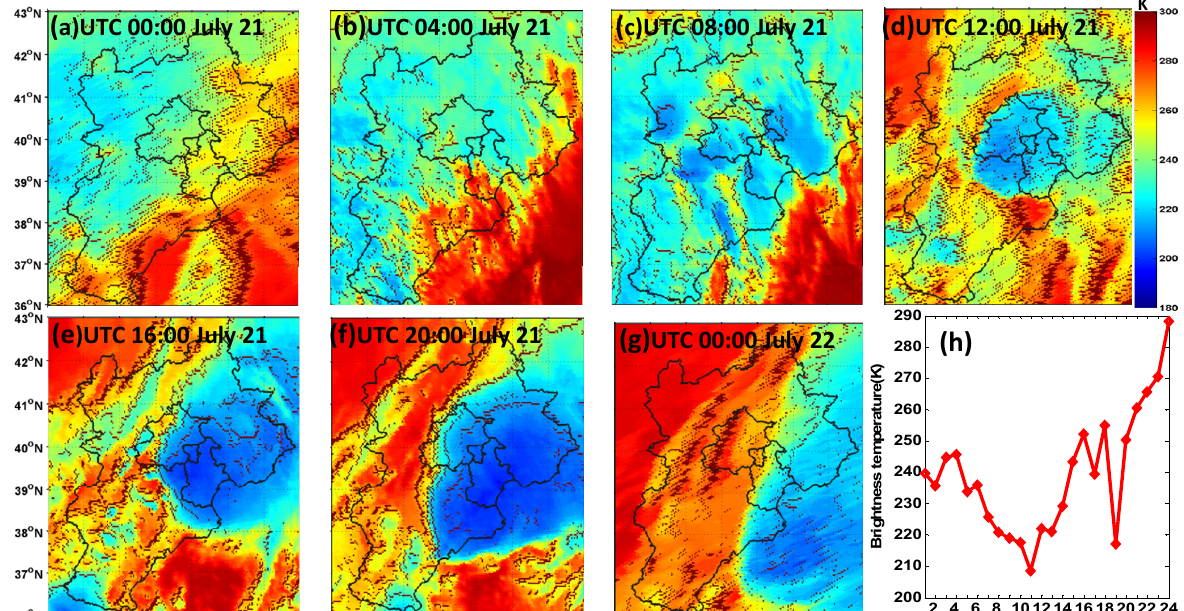
Figure 3. Cloud top time series brightness temperature map over the entire HBT domain ( a – h ) time series area-average brightness temperature at the rainfall center shown in Figure 2a. The brightness temperature data are provided by the Climate Prediction Center, National Oceanic and Atmospheric Administration